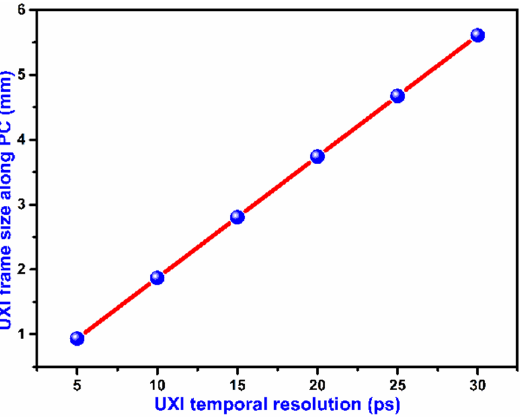
Figure 7. The relationship between the theoretical UXI frame size along the PC and the time resolu- tion.